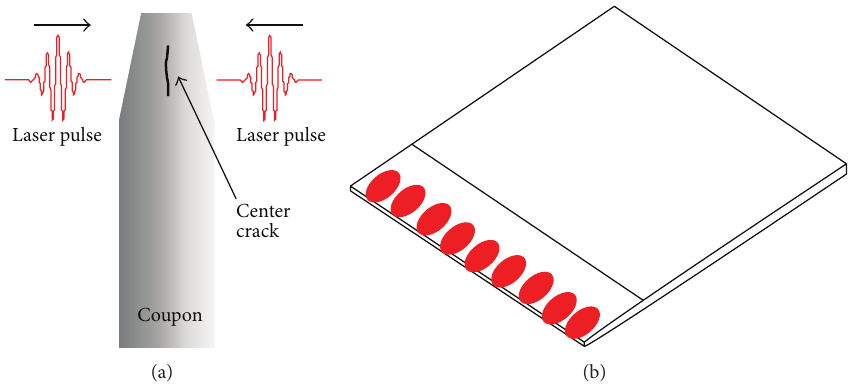
Figure 3: (a) Schematic of the two-sided peening process; (b) pattern of the laser spots along the tapered edge of the